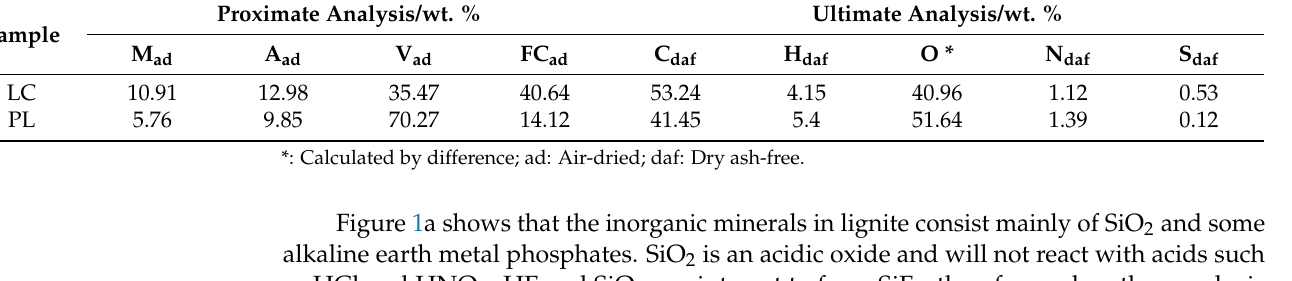
Table 1. Proximate analysis and elemental analysis of experimental raw materials. Proximate Analysis/wt. % Ultimate Analysis/wt. Sample